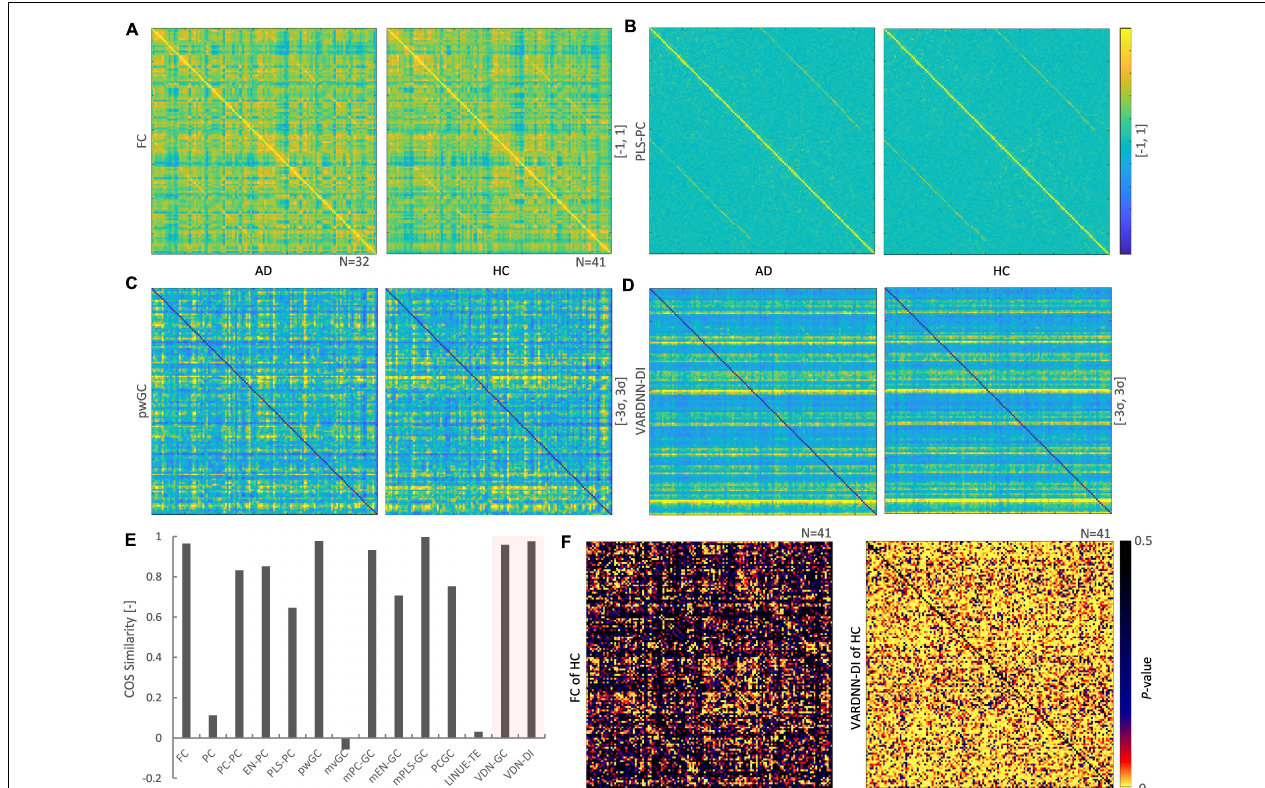
FIGURE 8 | (A) Left: mean FC matrix (132 × 132) of the AD group ( N = 32). Right: mean FC matrix of the HC group ( N = 41) Color range is [–1, 1]. Source is column, target is row. (B) Mean PLS-PC matrix (left: AD group, right: HC group). Color range is [–1, 1] (C) Mean pwGC matrix (left: AD group, right: HC group). Color range is [–3 σ , 3 σ ] (D) Mean VARDNN-DI matrix (left: AD group, right: HC group). Color range is [–3 σ , 3 σ ] (E) Cosine similarity of the mean matrix between the AD and HC group matrices. (F) Lilliefors test result matrix of FC (left) and VARDNN-DI (right) of